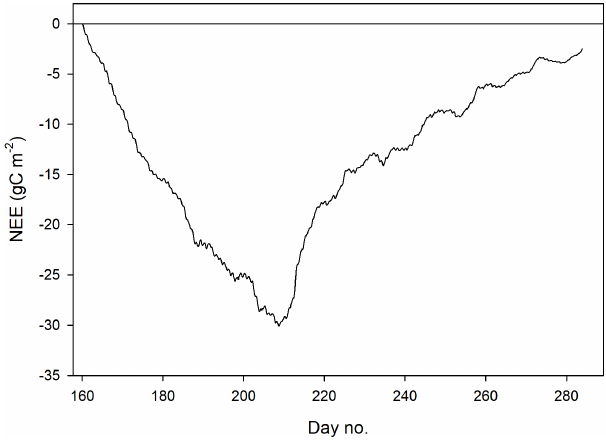
Figure 9. The cumulated half-hourly net ecosystem exchange (NEE) during the growing